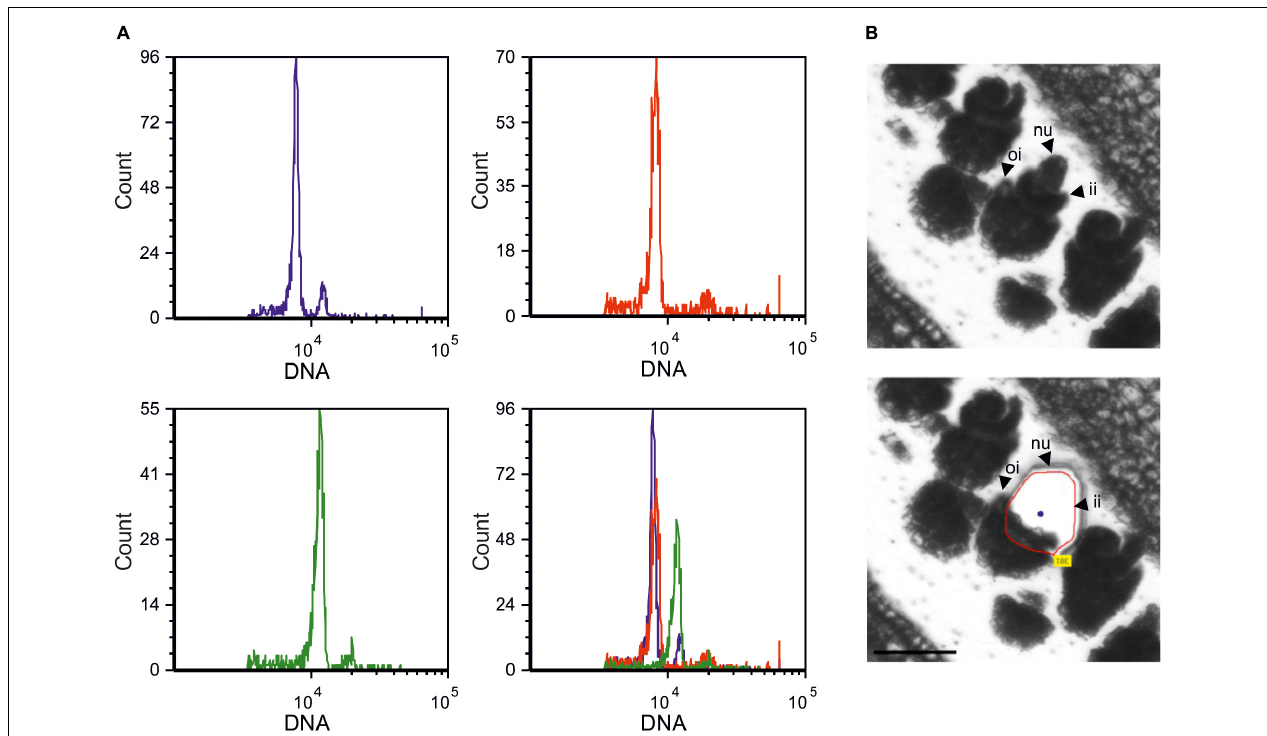
FIGURE 1 | Hypericum perforatum main reproductive strategies and tissue type investigated in this study. (A) DNA histograms displaying estimates of DNA content by using H. perforatum single seeds, as assessed by FCSS. Blue: seed originated by sexual reproduction (4:6 embryo:endosperm C-values); red: single seed originated by autonomous apomixis (4:8 embryo:endosperm C-values); green: BIII hybrid (6:8 embryo:endosperm C-values). The overlay of these three profiles is also shown. (B) Ovule developmental stage adopted for Laser-Capture Microdissections (upper panel). The remaining tissue is displayed in the bottom panel. Dissections were performed by targeting the ovule nucellus (red line). nu: nucellus; ii: internal integuments; oi: outer integuments. Scale bar: 50 mm.